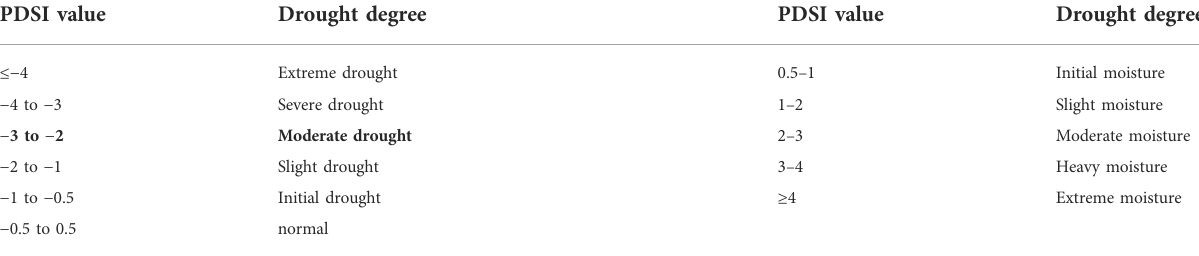
TABLE 1 The correspondence between PDSI values and drought degree.